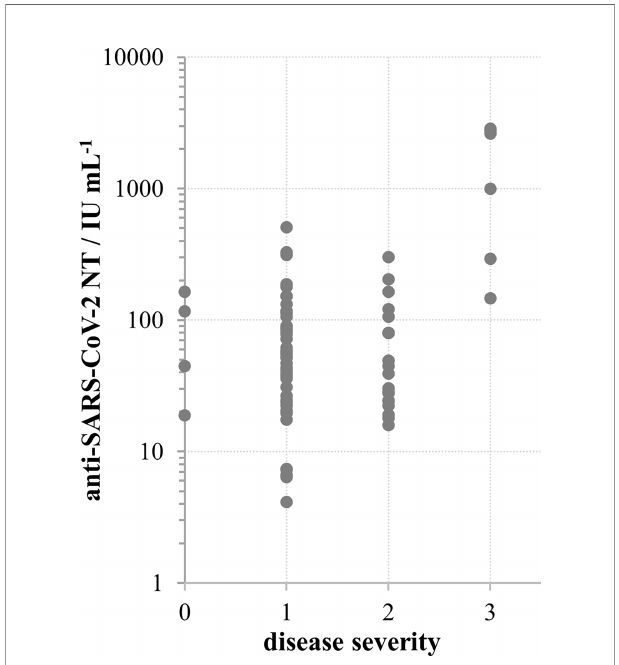
FIGURE 4 | SARS-CoV-2 neutralisation titre in convalescent donors ’ sera in relation to disease severity according to scale: 0 – no symptoms, 1 – mild, 2 – moderate, 3 – severe; * p < 0.002 in comparison to other groups, calculated by Kruskal-Wallis